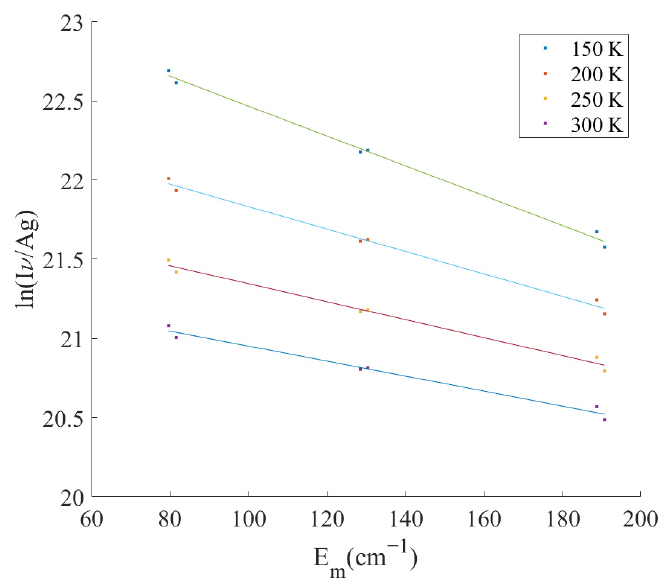
Figure 13. The straight line fitted by the 6 emission lines at different temperatures. Based on the observed radiance data, the above peak relative intensity ratio method is conducted for the synchronous retrieval of atmospheric temperature in the whole range of tangent height. The retrieval of atmospheric temperature in MLT, and the bias between retrieved temperature and actual temperature at different tangent heights were shown in Figure 14a,b.